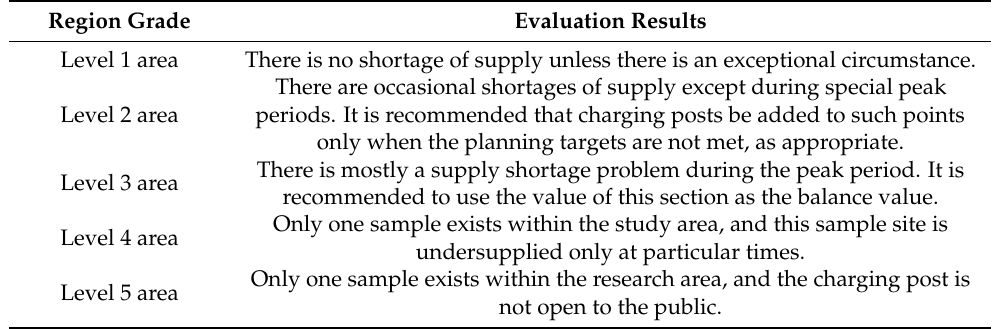
Table 1. Evaluation results of each grading area. Region